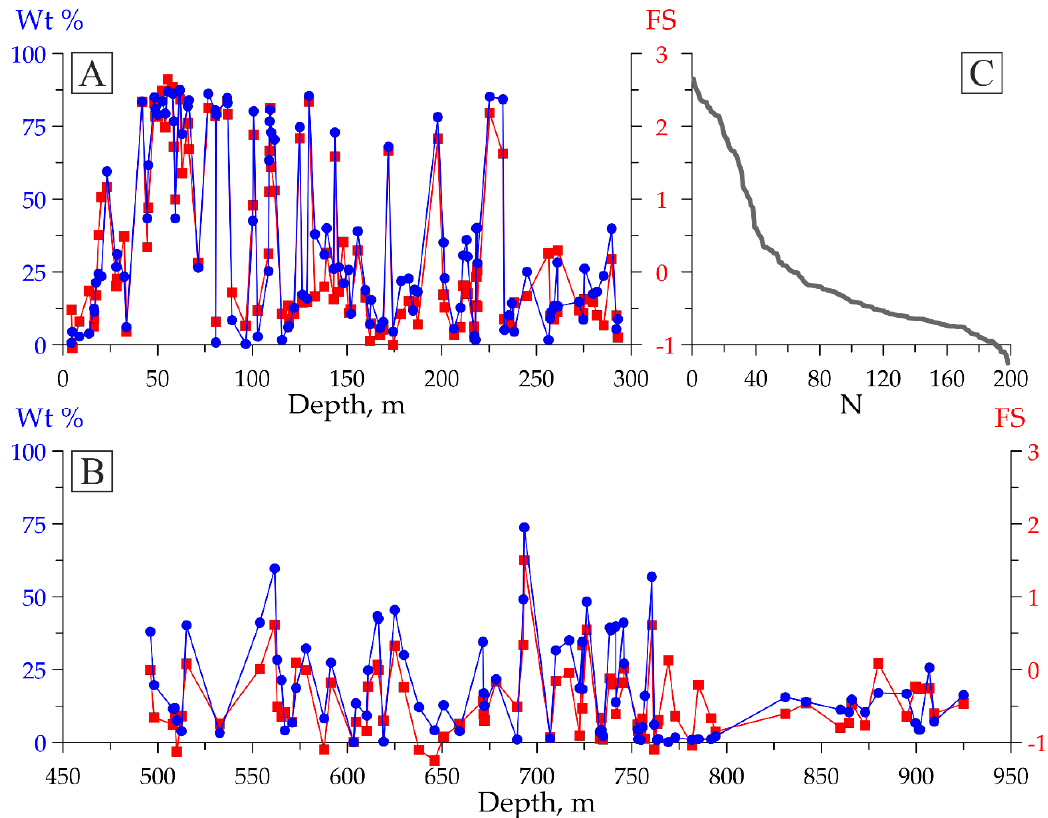
Figure 4. Comparison of graphs of calcite content (blue lines) and calcite FS (red lines) in cores of drill holes: ( A ) #7 (explosion pipe) and ( B ) #6 (carbonatite sequence); ( C ) ranked range of FS values of the calcite factor.